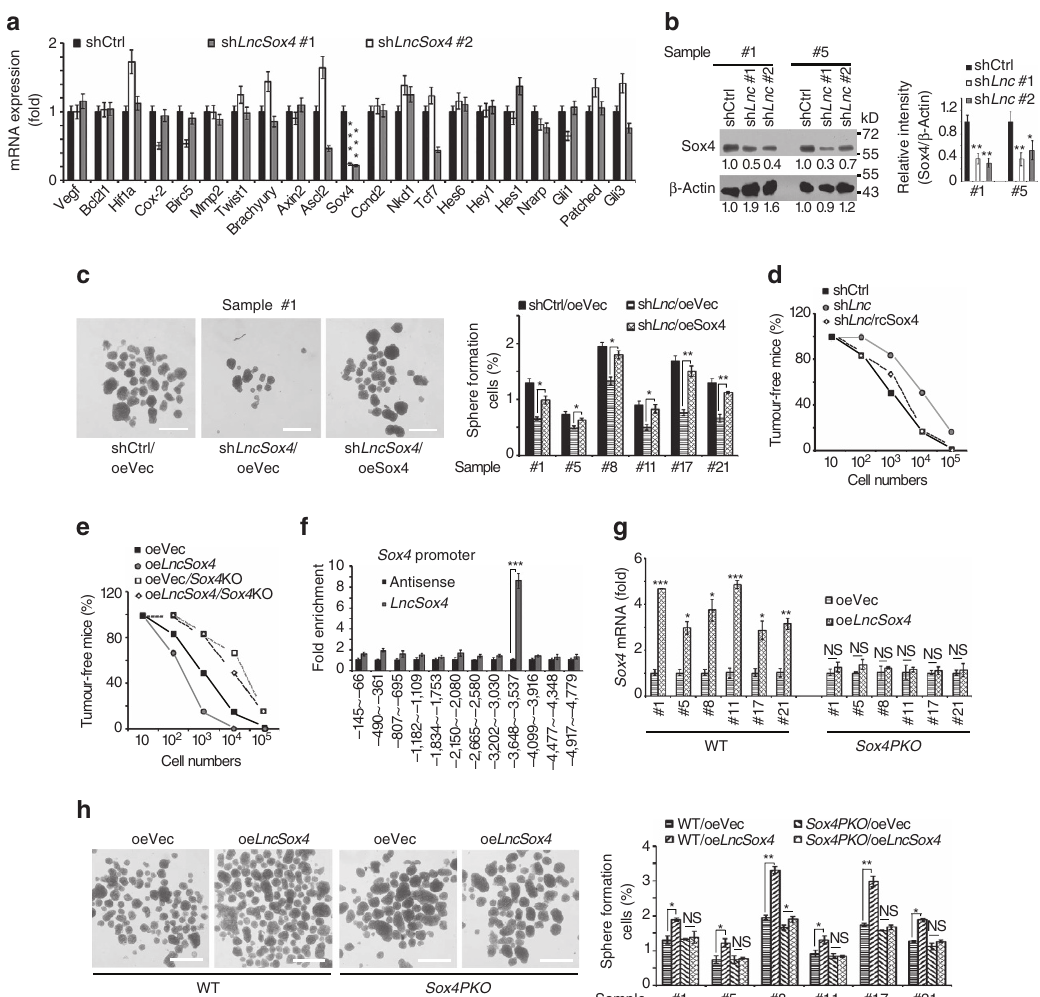
Figure 3 | LncSox4 drives liver TIC self-renewal through Sox4. ( a , b ) LncSox4 is required for Sox4 expression. mRNA expression of the indicated genes in LncSox4 -silenced (sh LncSox4 ) and control cells (shCtrl) were examined using real-time PCR ( a ). Impaired Sox4 expression in LncSox4 -silenced cells was confirmed by western blot ( b ). ( c , d ) LncSox4 drives liver TIC self-renewal through Sox4 expression. Sox4 expression was rescued using PBPLV lentivirus in LncSox4 -silenced cells, and then sphere formation ( c ) and tumour initiation ( d ) assays were performed. Five thousand indicated primary HCC cells were used for sphere formation, and 10, 1 (cid:2) 10 2 , 1 (cid:2) 10 3 , 1 (cid:2) 10 4 and 1 (cid:2) 10 5 cells were subcutaneously injected into BALB/c nude mice for tumour initiation. ( e ) Primary HCC cells were treated with CRISPR/Cas9 lentivirus for Sox4 deficiency, followed by LncSox4 overexpression (oeLnc). The indicated cells were used for in vivo tumour initiation, and the ratios of tumour-free mice were calculated 3 months later. ( f ) LncSox4 binds to Sox4 promoter. RNA ChIP assay was performed and fold enrichment was examined using real-time PCR. ( g , h ) The interaction of LncSox4 and Sox4 promoter was required for LncSox4 function. The Sox4 promoter region for LncSox4 binding ( (cid:3) 3,647 B (cid:3) 3,537) was deleted using CRISPR/Cas9 approach ( Sox4PKO ), followed by LncSox4 overexpression. The established cells were examined for Sox4 expression and sphere formation capacities. Six samples were examined and similar results were found. Scale bars, C, H 500 m m. Data were shown as means ± s.d. Two-tailed Student’s t -test was used for statistical analysis. * P o 0.05; ** P o 0.01; *** P o 0.001. P o 0.05 was considered significant. Data are representative of three independent experiments. For b , the original images are shown in Supplementary Fig. 6. NS, not